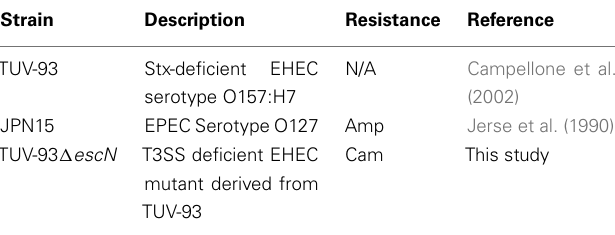
Table 1 | Bacterial strains used in this study. Strain Description Resistance